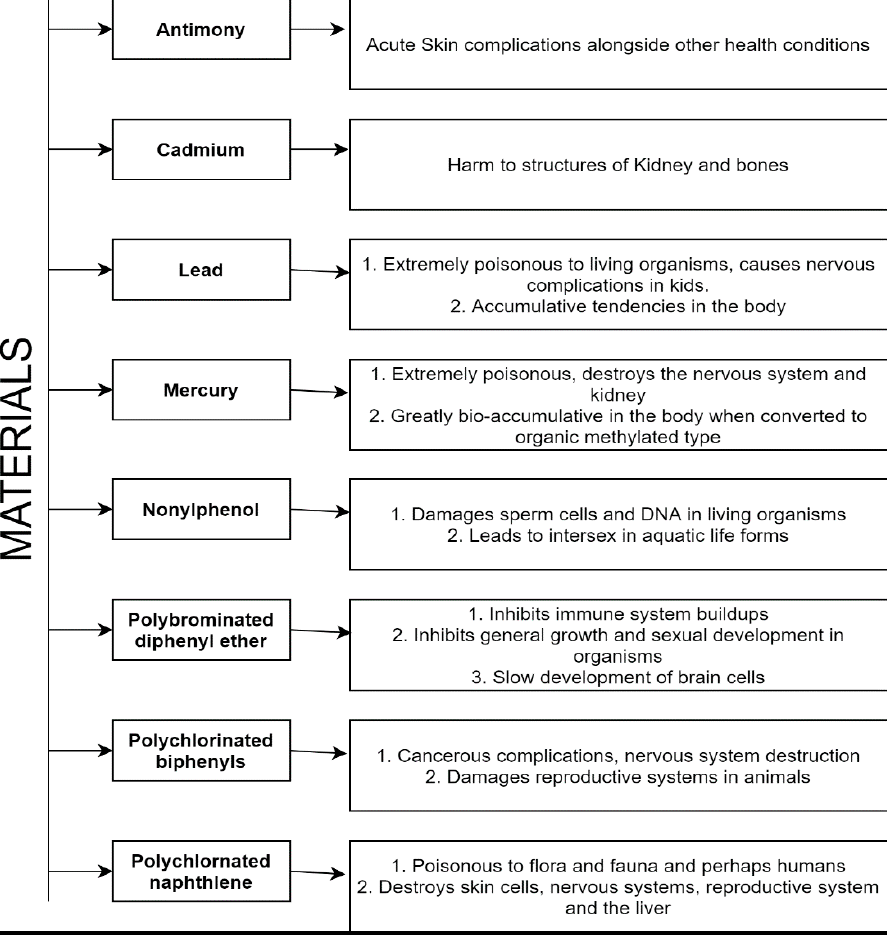
Figure 6. Materials and health threats. Source: [38].